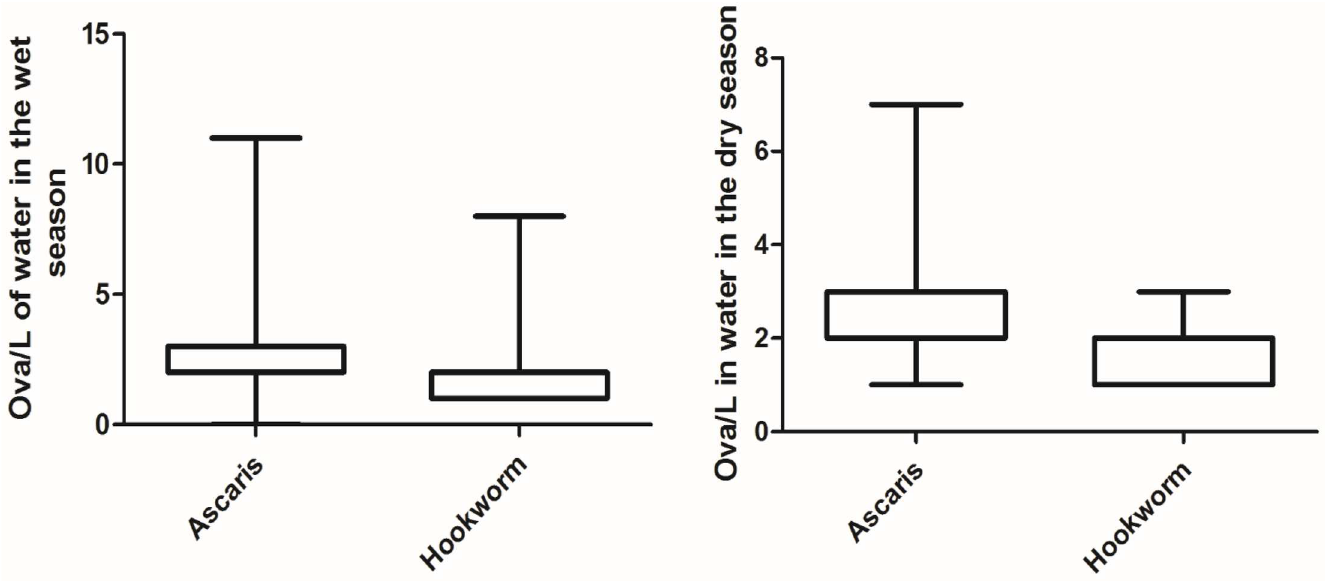
Fig 2. Distribution of Ascaris spp and hookworm ova in irrigation water in the dry (n = 71) and wet (n = 107) seasons. doi:10.1371/journal.pntd.0005161.g002 for the farmers and 6.00% (n = 100) for the control group. Similarly, the prevalence of hook- worm infection in the wet season was 12.73% (n = 165) for the farmers and 2.00% (n = 100) for the control group. In the dry season prevalence of Ascaris spp. was lower for both groups, the farmers had a prevalence of 11.02% (n = 127) and 5.74% (n = 52) for the control group. A much lower prevalence was recorded for hookworm infections for farmers with 4.72%